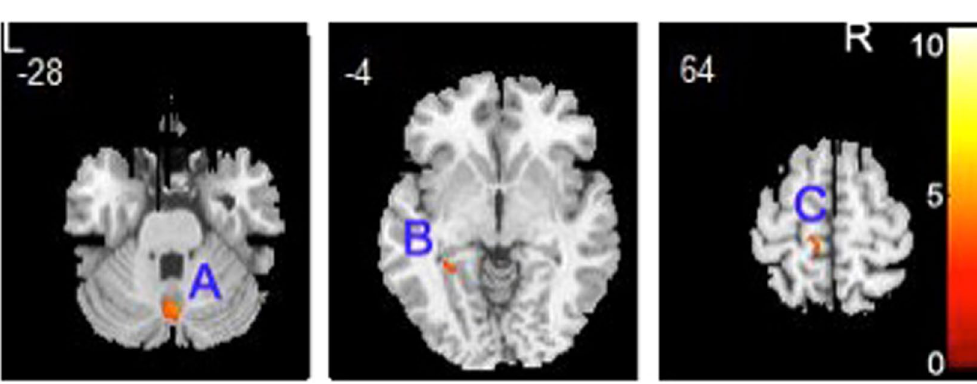
Figure 2. Relative to healthy controls, patients with adolescent-onset schizophrenia showed gray matter volume deficits in the left parietal postcentral gyrus, parahippocampal gyrus and right cerebellum posterior pyramis ( A ). Right cerebellum posterior pyramis ( B ). Left parahippocampal gyrus ( C ). Left parietal postcentral gyrus.